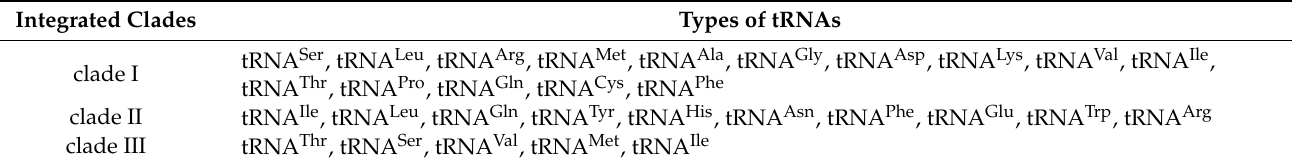
Table 4. The distribution of types of tRNAs in the three major clusters of the phylogenetic tree. Integrated Clades Types of tRNAs clade